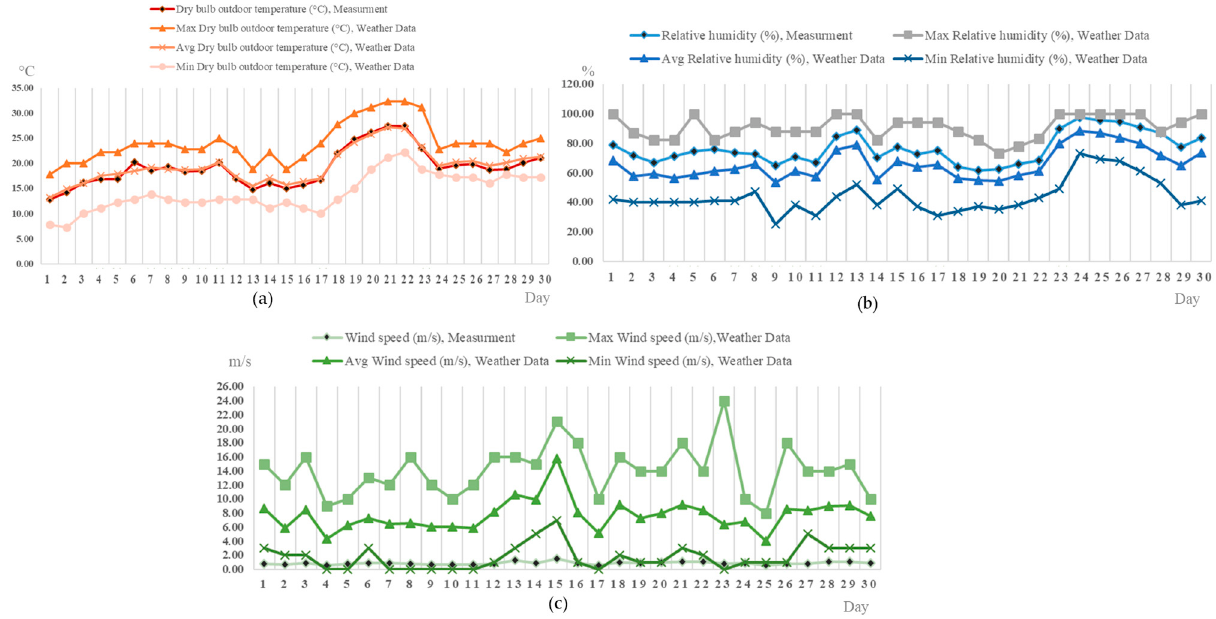
Figure 3. Tallinn, Estonia Weather History, June 2021 [40]. ( a ) Dry bulb temperature, ( b ) relative humidity, and ( c ) wind speed.